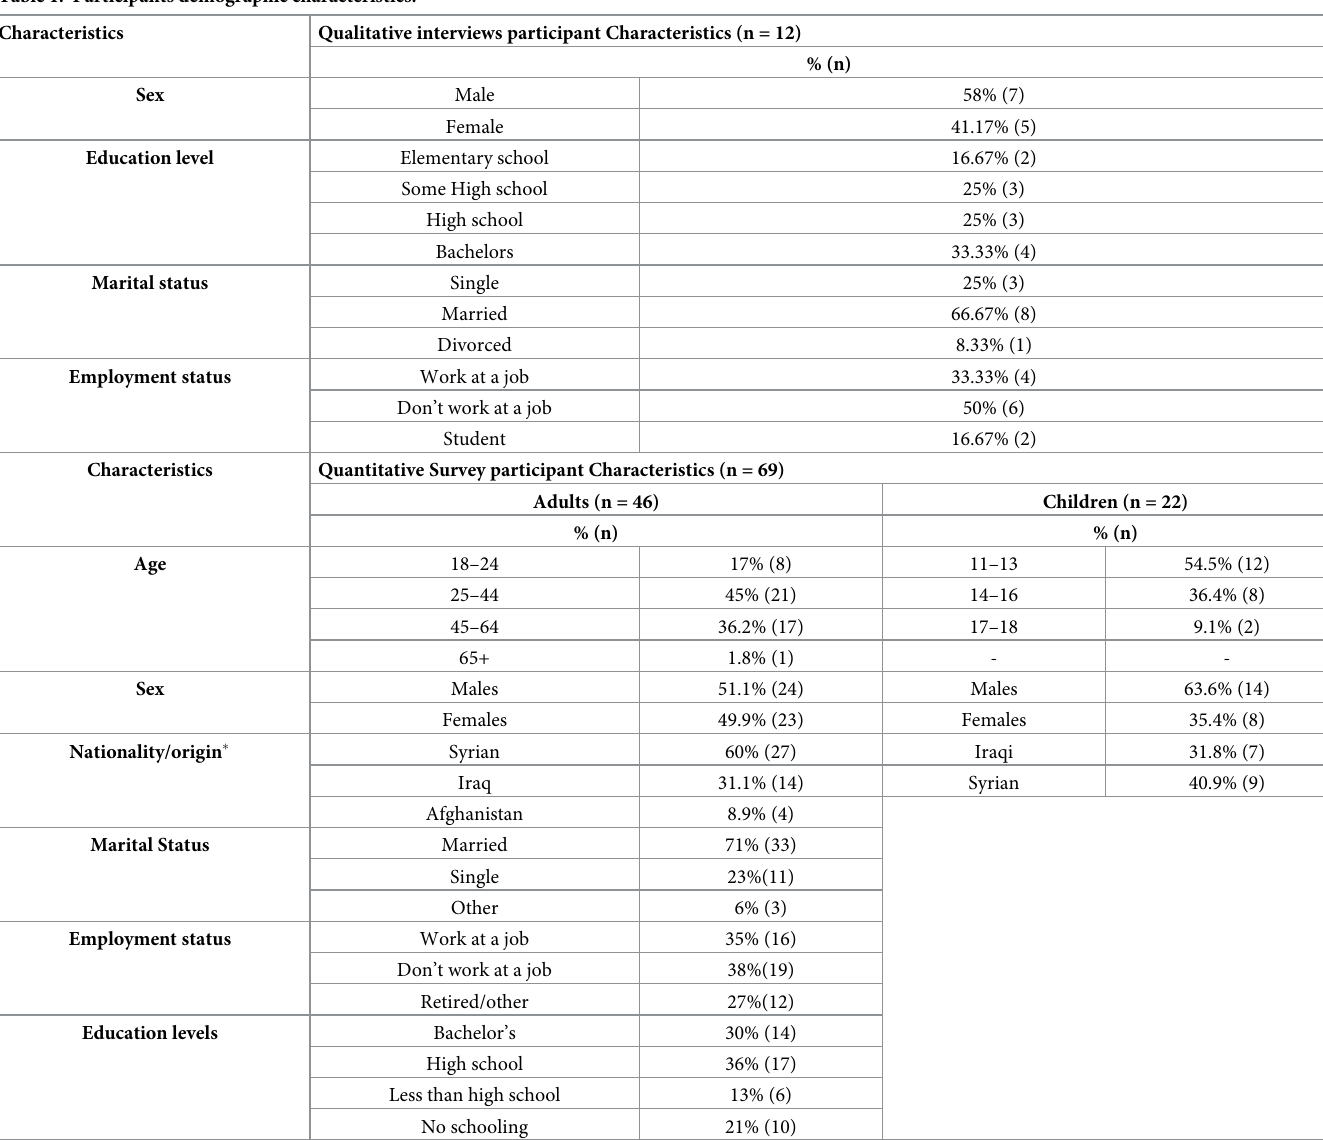
Table 1. Participants demographic